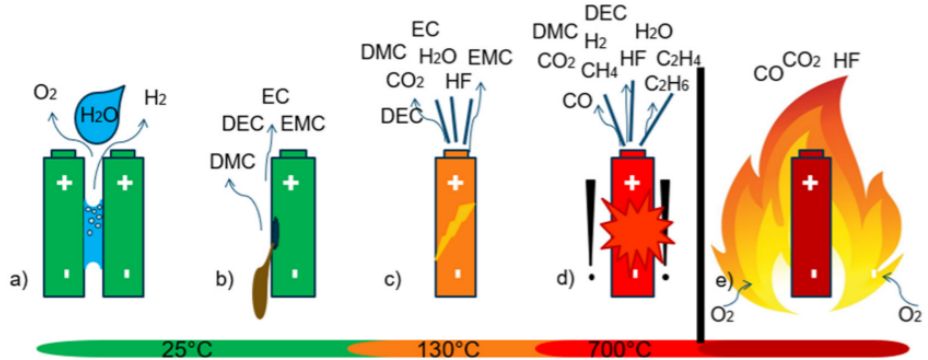
Figure 10. Battery failure modes, which involve the emission of gaseous species: ( a ) electrolysis due to the presence of water between positive and negative poles of the cells, ( b ) evaporation of electrolyte from damaged cells, ( c ) early venting from a failing cell, ( d ) the thermal runway (TR), and ( e ) battery fire. Adapted from